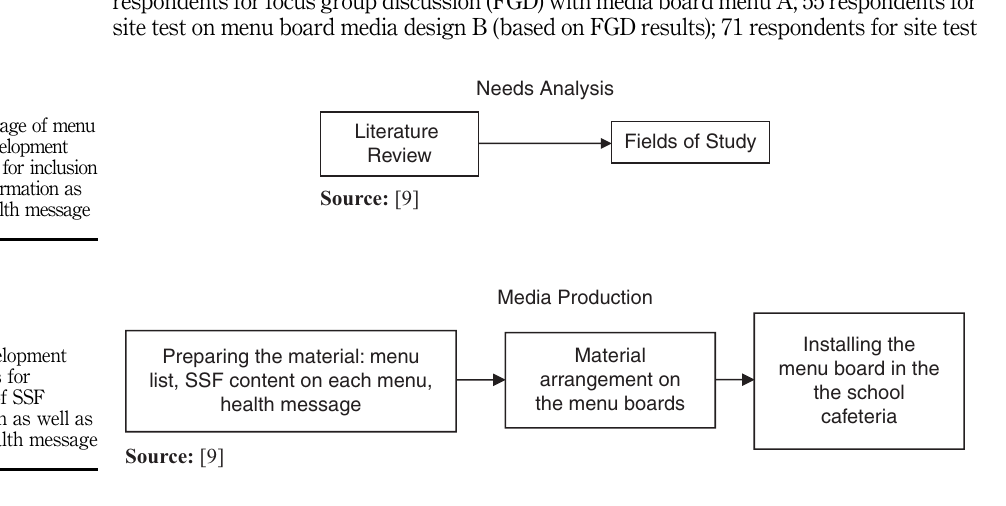
Figure 2. Menu development procedures for inclusion of SSF information as well as a third health